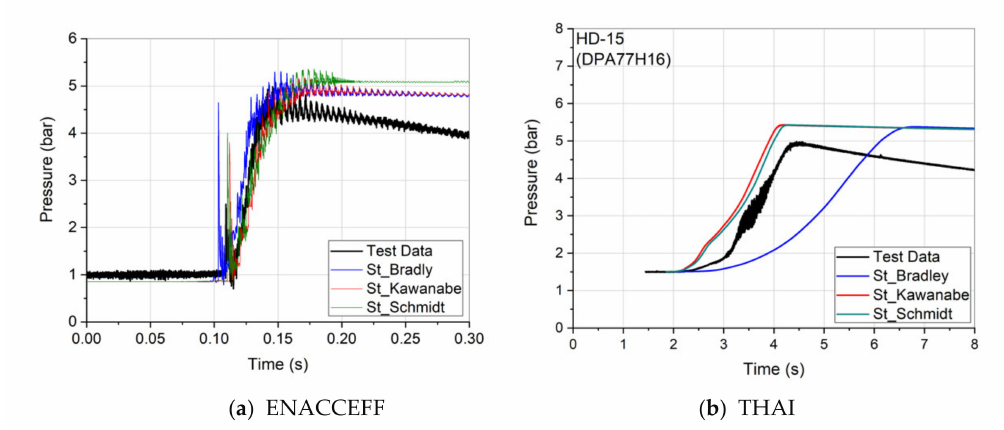
Figure 2. COM3D validation results against the test data